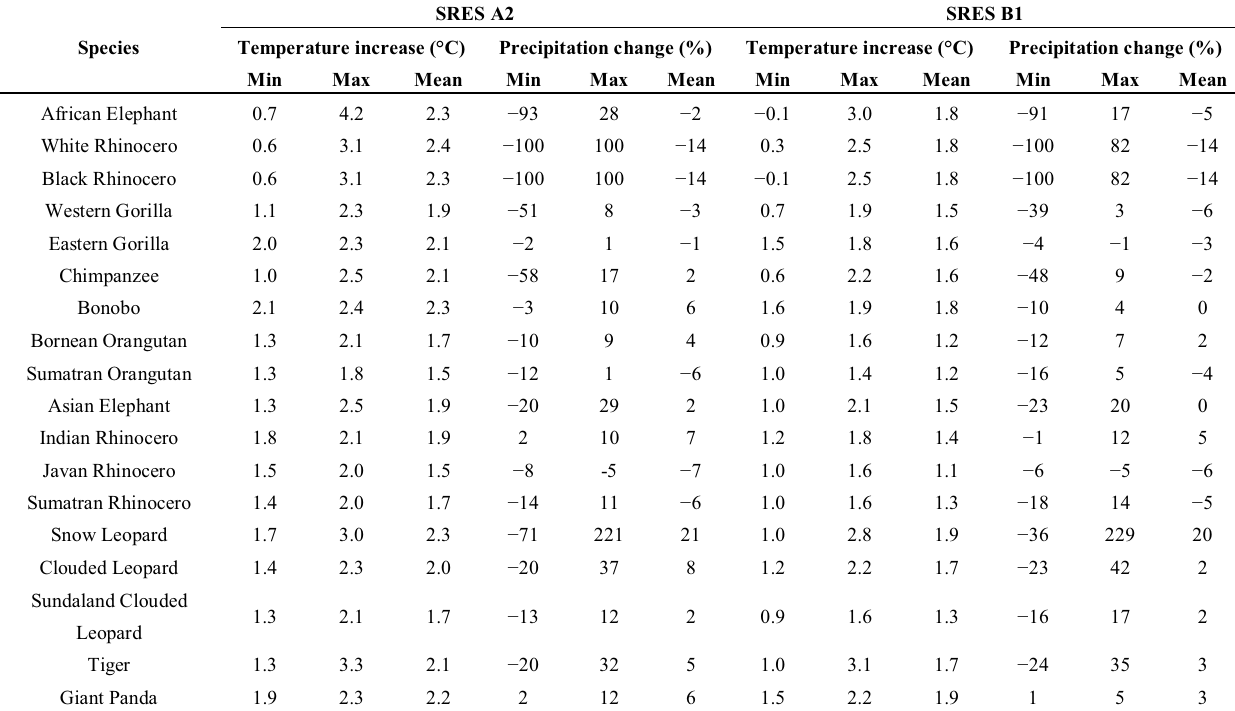
Table 4. Projected changes in temperatures and precipitation in species (cid:182) distribution range (terrestrial